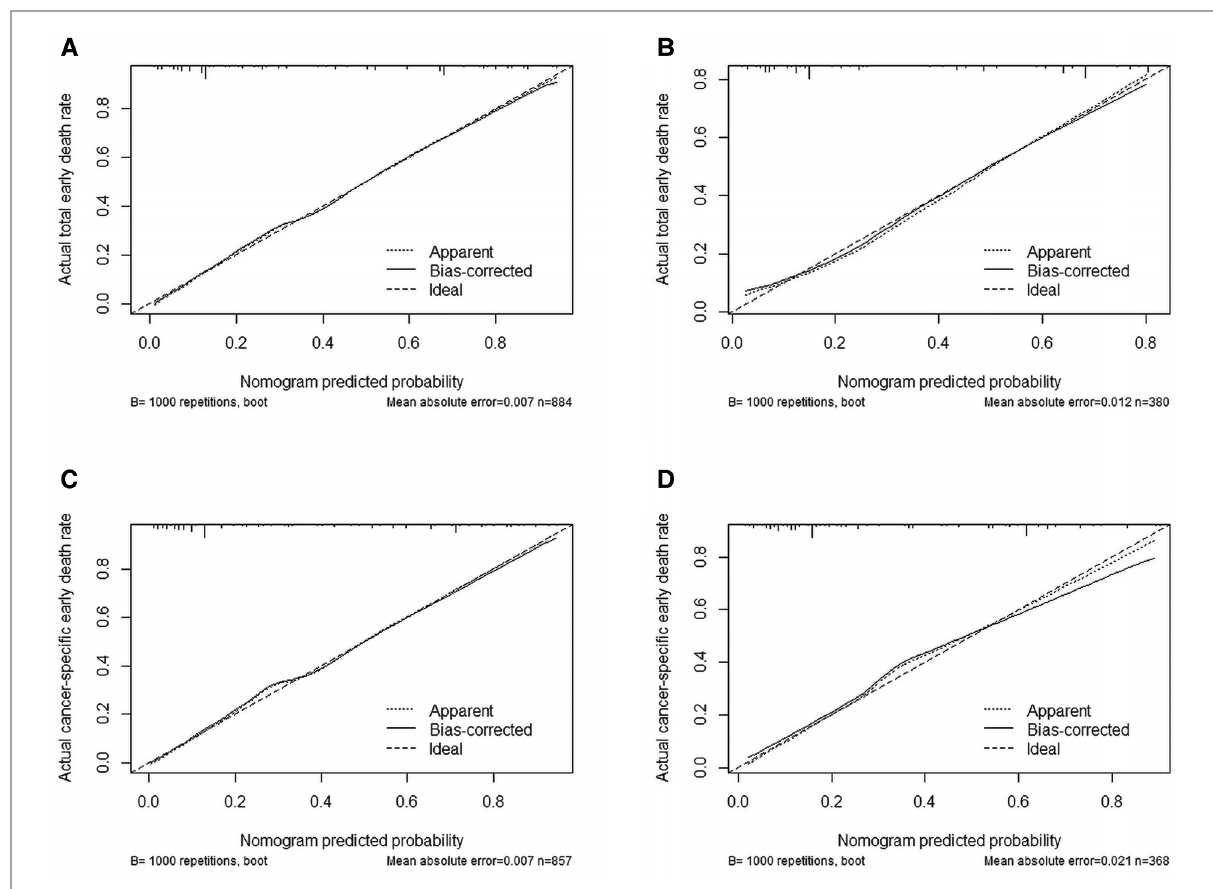
FIGURE 5 Internal veri fi cation plots of nomogram calibration curves by bootstrapping with 1,000 resamples. ( A ) The training cohort of total early death; ( B ) The validation cohort of total early death; ( C ) The training cohort of cancer-speci fi c early death; ( D ) The validation cohort of cancer-speci fi c early